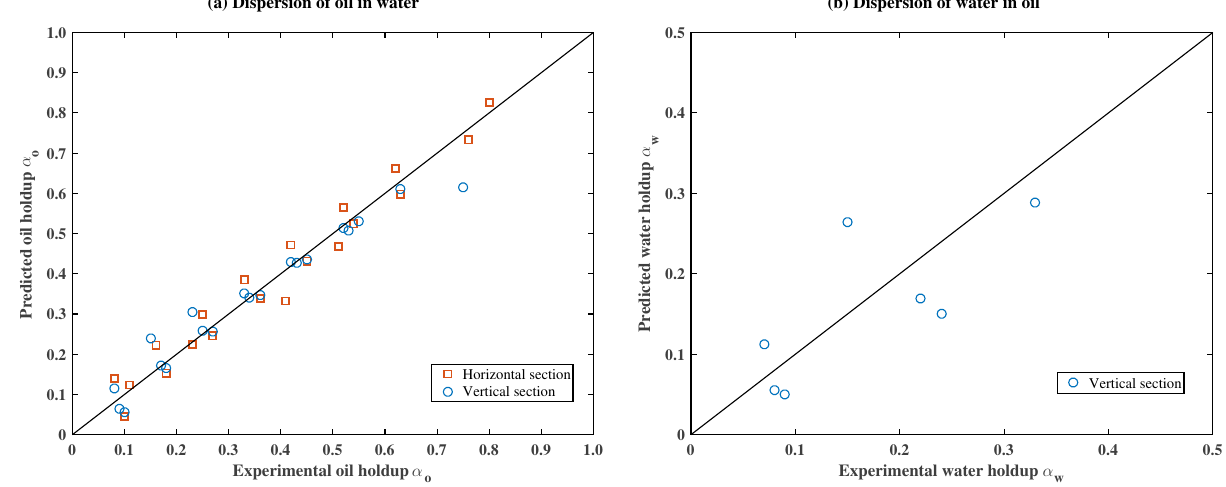
Figure 11. Comparison between the predicted dispersed phase holdup with the experimental data for ( a ) dispersion of oil in water flow pattern and ( b ) dispersion of water in oil flow